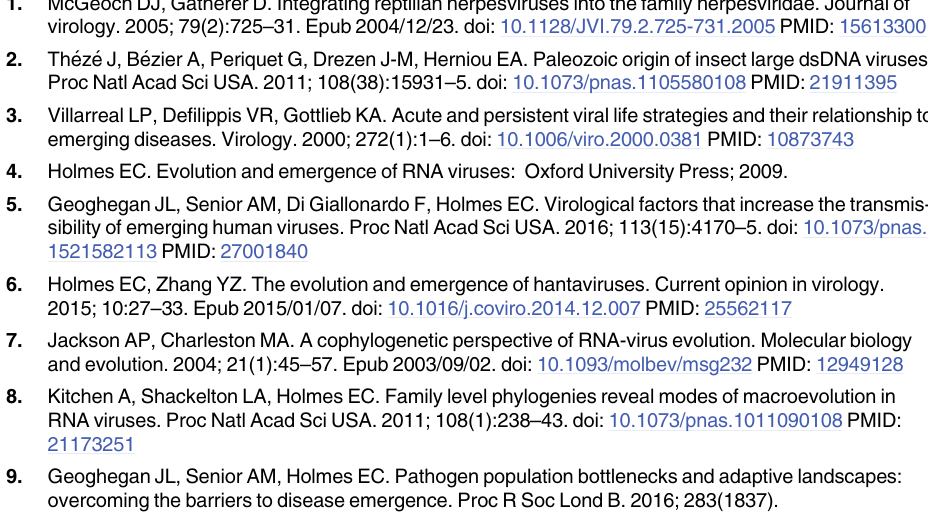
S1 Table. GenBank accession numbers for the virus and host genetic sequence data utilized here. S2 Table. Summary of the virus and host diversity included and excluded in this study. Virus genera were excluded either due to lack of available data or because we were unable to obtain a reliable alignment of sufficient length for phylogenetic analysis (i.e. at least 100 amino acids after trimAl pruning). S3 Table. Overall nPH85 distances, means and 95% percentiles between two unrooted phy- logenetic trees for each virus family determined using the normalized Penny and Hendy [14] topological distance method, implemented in in NELSI v0.1 [45]. The overall nPH85 distances are illustrated in Fig 2 in the main